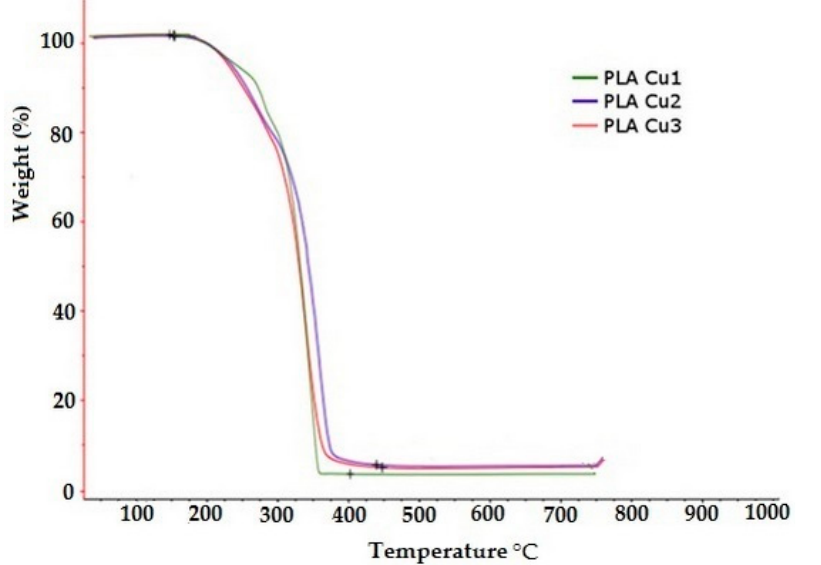
Figure 10. Thermogravimetric analysis (TGA) for the PLA-Cu samples. Table 6. The temperature at which the sample loses 15% by weight. Sample Temperature for Mass Loss of 15% by Weight, ◦ C